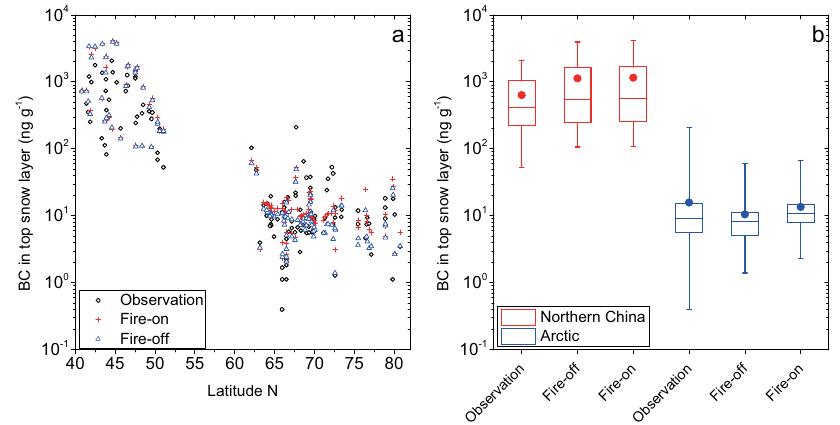
Figure 9. Evaluation of CAM5-simulated black carbon (BC) concentration for the period of 2003–2011 (in ngg − 1 ) in the top snow layer against observations in the Arctic (Doherty et al., 2010) and northern China (Wang et al., 2013b). The top snow layer ranges in thickness from 1 to 3cm. Configuration of the two CAM5 simulations (FIRE and NOFIRE) is summarized in Table 1. Panel (a) shows the comparisons at different latitudes. The box and whisker plot in (b) shows the minimum and maximum value with the bar, the 25th and 75th percentiles with the box, the 50th percentile (i.e., median) by the bar within the box and the mean value with the